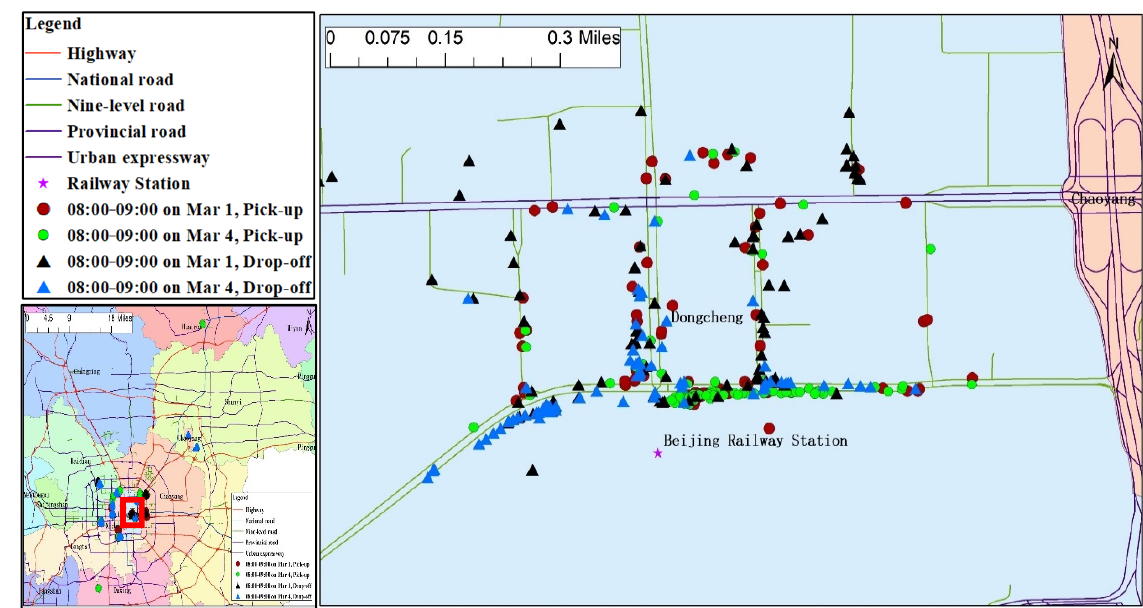
Figure 7. Example of a hot pick-up and drop-off area during the same time period on different days.